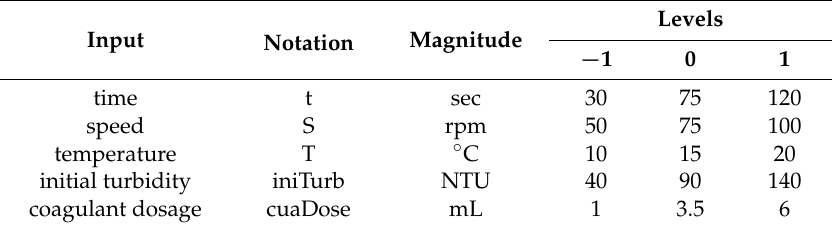
Table 2. Parameters of the coagulation process and